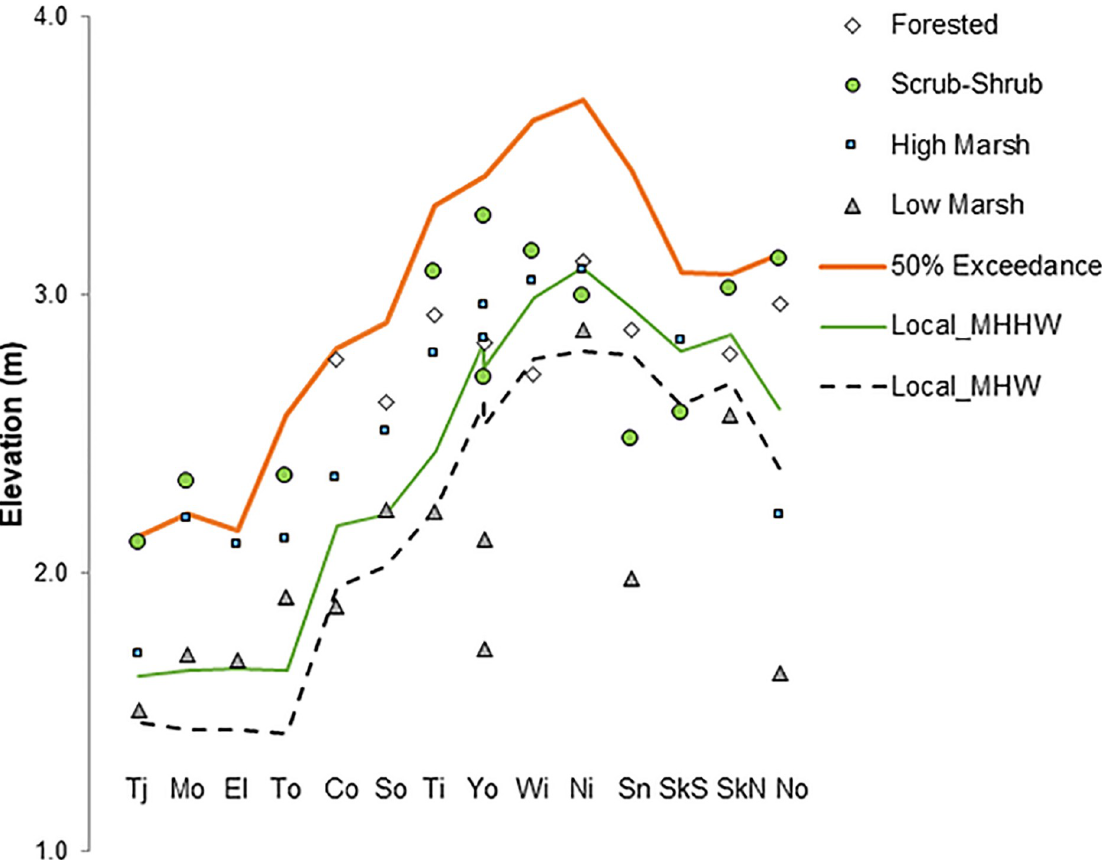
Fig 2. Observations of elevational data (relative to NAVD88) from 14 estuary systems across California, Oregon, and Washington. Estuaries (south to north in order from left to right) evaluated include Tijuana (TJ), Morro Bay (Mo), Elkhorn Slough (El), Tomales Bay (To), Coquille (Co), South Slough (So), Tillamook (Ti), Young’s Bay (Yo), Willapa Bay (Wi), Nisqually (Ni), Snohomish (Sn), South Fork Skagit (SkS), North Fork Skagit (SkN), and Nooksack (No). In contrast to MHHW (green line) and MHW (black line), 50% exceedance elevation (orange line) consistently surpasses average lidar-based elevations of all four tidal wetland types (other symbols) which were verified as tidally inundated in the field (S2 File).